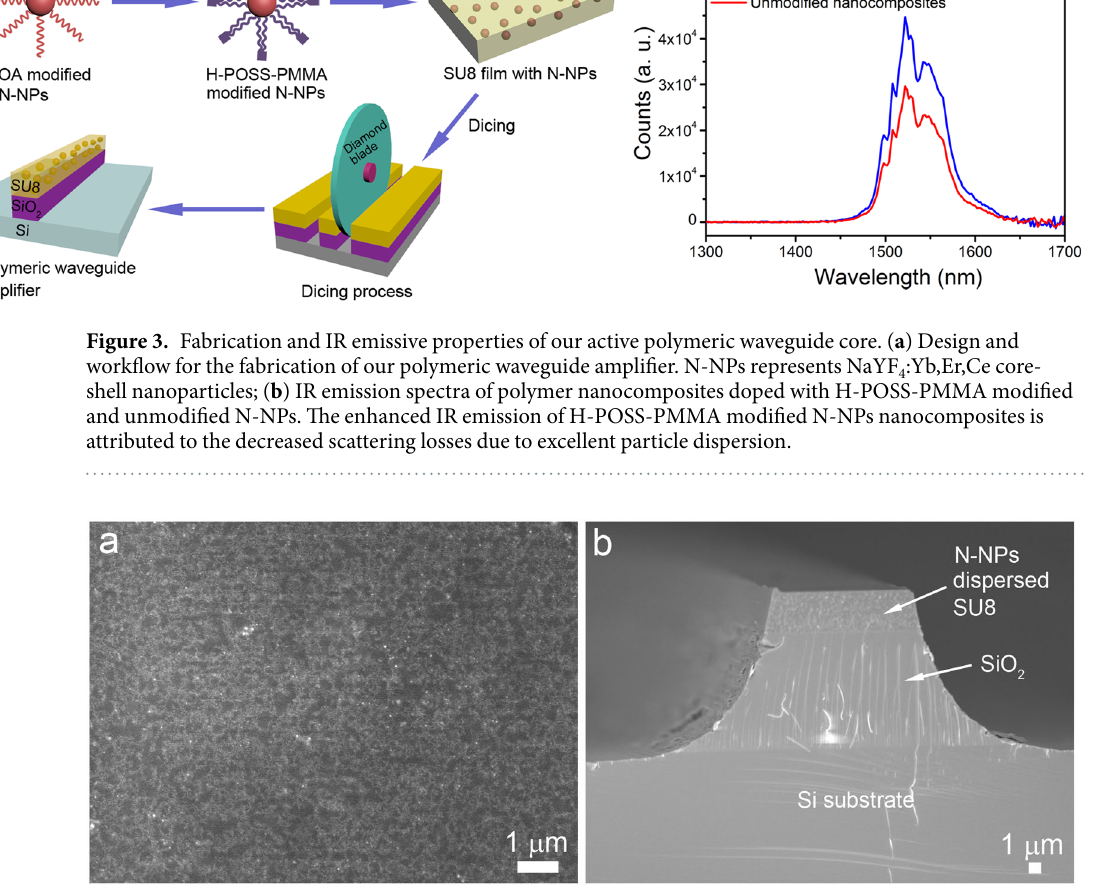
Figure 4. Microstructure of uniformly dispersed N-NPs in SU8 at a high loading of 6 vol%. SEM showing the ( a ) top view of N-NPs dispersed SU8 nanocomposite and ( b ) cross section of the fabricated polymeric waveguide amplifier on the SiO 2 layer on a Si